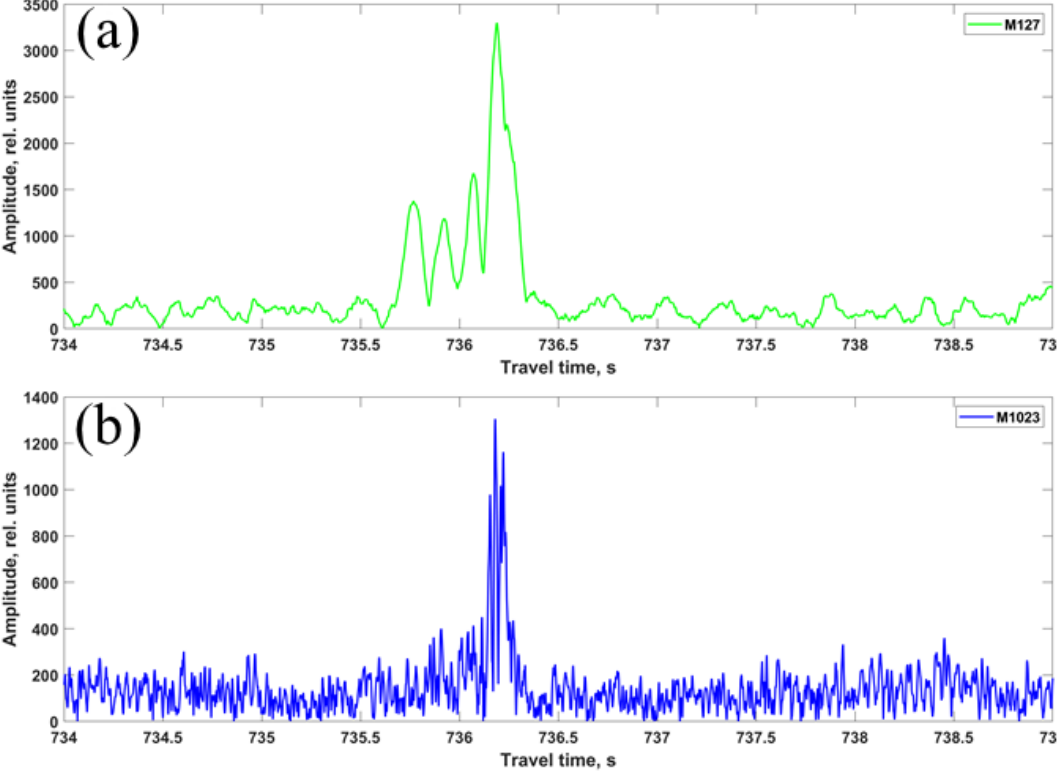
Figure 17. Impulse responses of the received signals: ( a ) M127; ( b ) M1023.